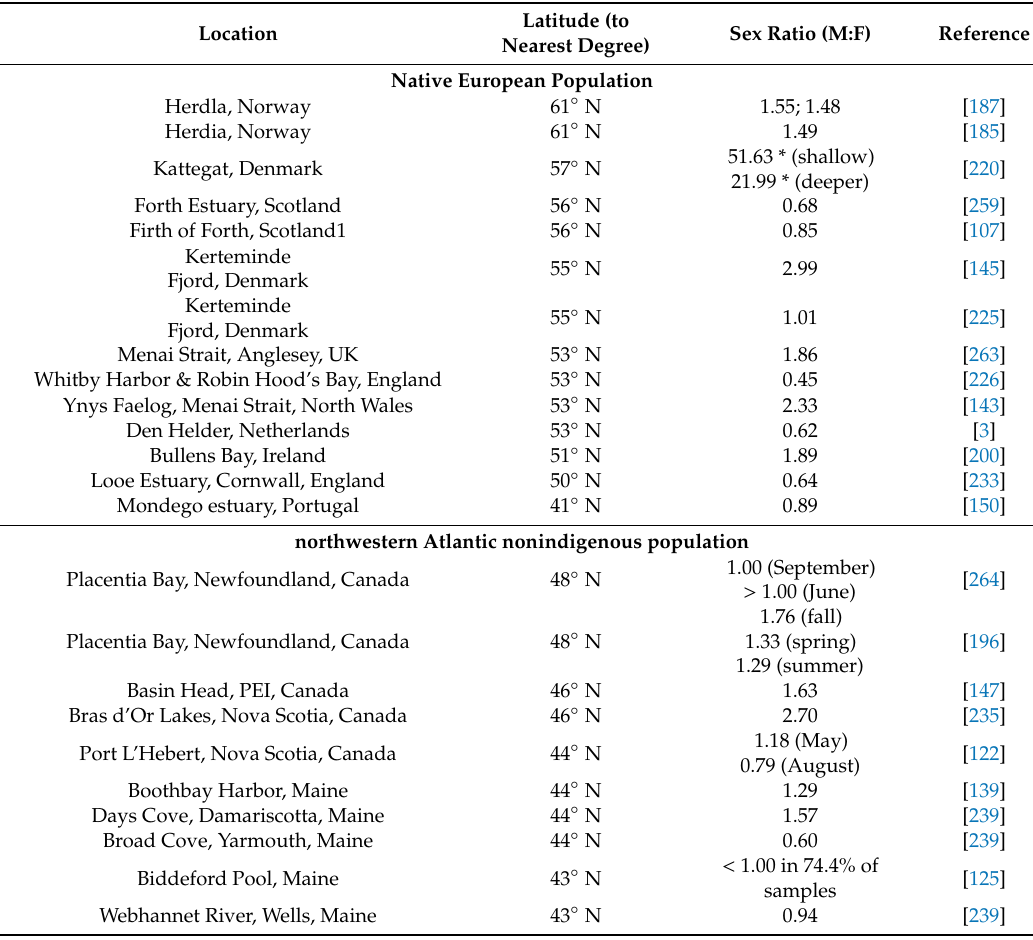
Table 3. Sex ratios (M:F) for various populations of C. maenas . Value > 1 indicates a higher proportion of males; value < 1 indicates a higher proportion of